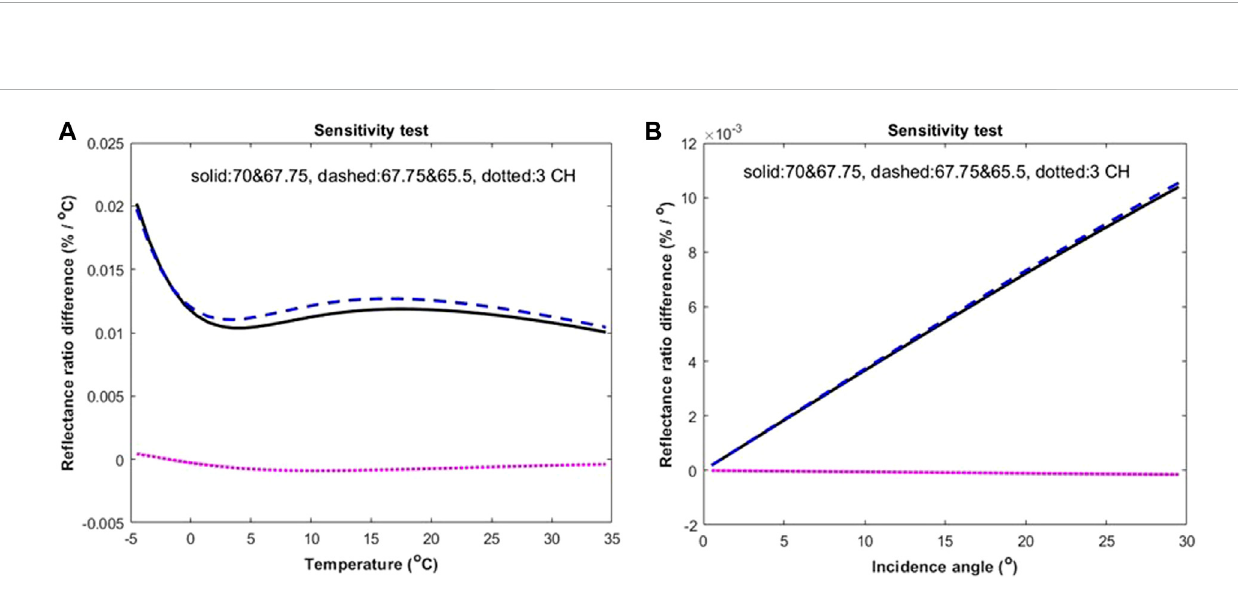
FIGURE 6 Similartoprevious fi gures,exceptforsensitivitytestson (A) SSTwith1 ° Cerrorand (B) incidenceanglewith1 ° errorforseasurfacere fl ectanceratiosofthe two frequency-pairs and three-channel